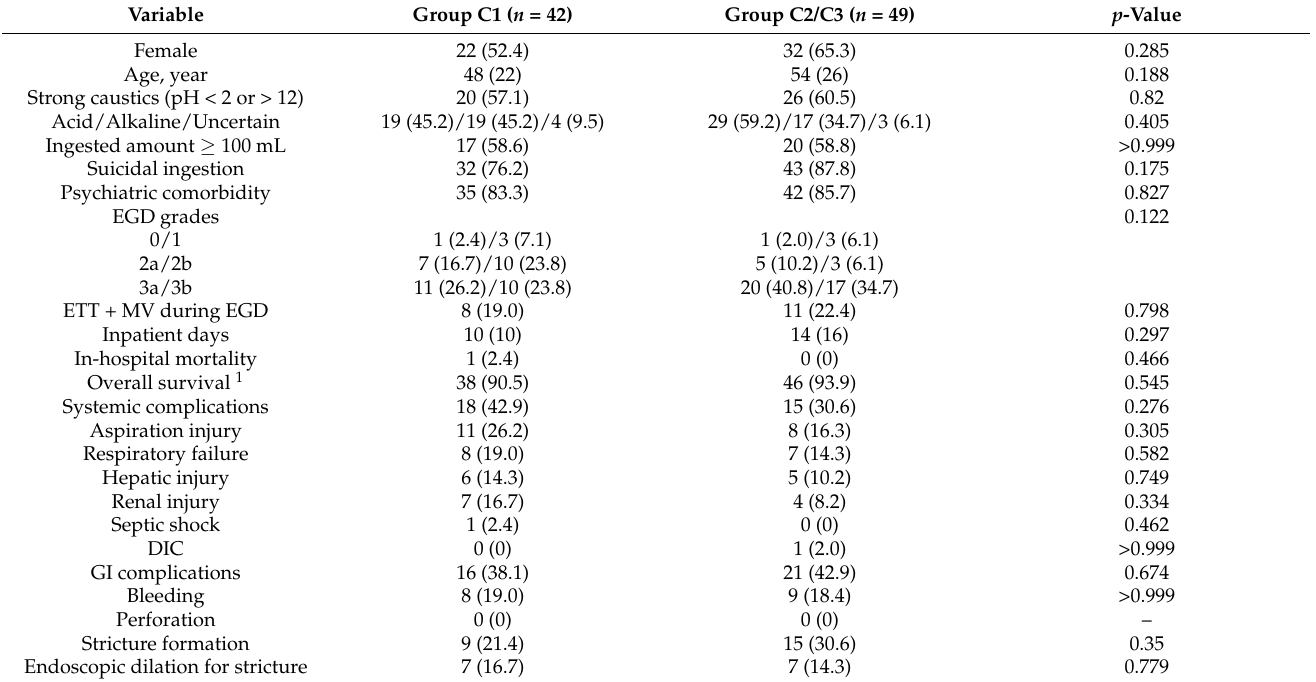
Table 2. Demographic characteristics between group C1 (not receiving CT) and group C2/C3 (re- ceiving CT).